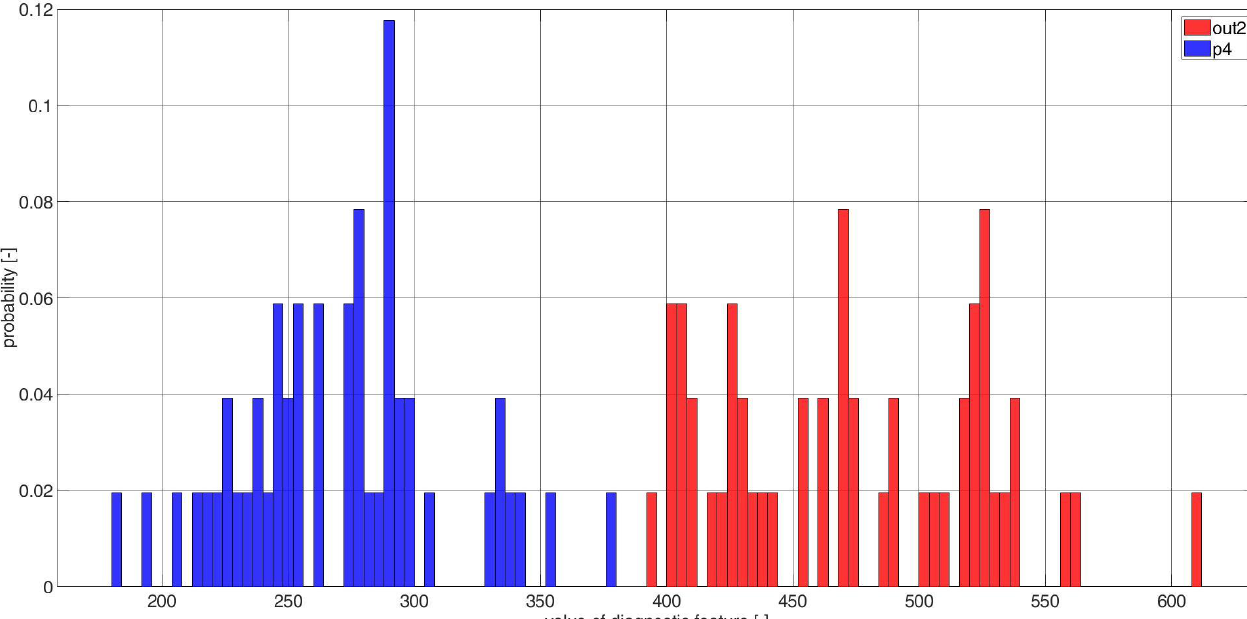
Figure A27. Histogram of diagnostic features based on the CCSM3 (correlation number is 1 — Table A2) bearings out1 and p3.